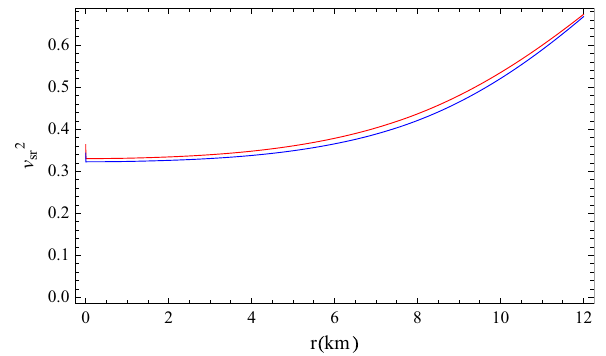
Fig. 16 Variationof v 2 rc with r forPSRJ0348+0432considering β = 1 and matter distribution following Chaplygin EoS [ α = 0 (blue) and α (cid:5)= 0 (red)] Δ is plotted in Fig.19 for α = 0 (blue) and α (cid:5)= 0 (red)